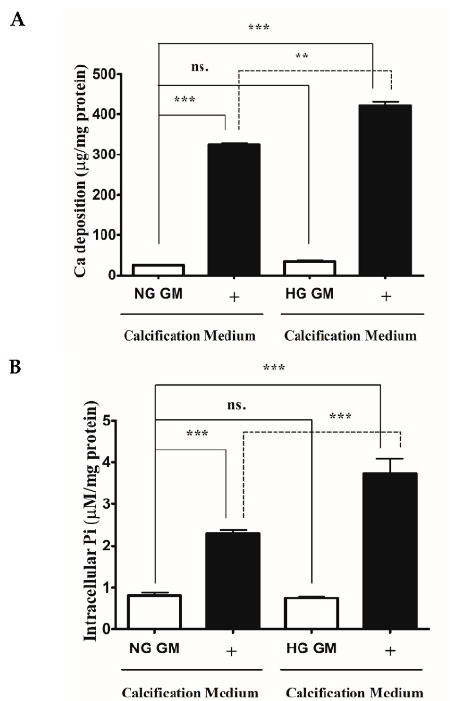
Figure 1. High glucose aggravates Pi-induced ECM calcium deposition and Pi uptake of VSMCs. VSMCs were cultured in calcification medium containing 3 mmol/L inorganic Pi under normal glucose (5.5 mM glucose) and high glucose (11 mM) conditions for 10 days. ( A ) Calcium content of solubilized ECM is presented. Data are expressed as mean ± SEM of three independent experiments. ( B ) Intracellular Pi levels are presented as mean ± SEM of three independent experiments. Statistical analysis was performed by the one-way ANOVA test followed by Bonferroni correction. A value of p < 0.05 was considered significant. ns: Non-significant; ** p < 0.01, *** p <